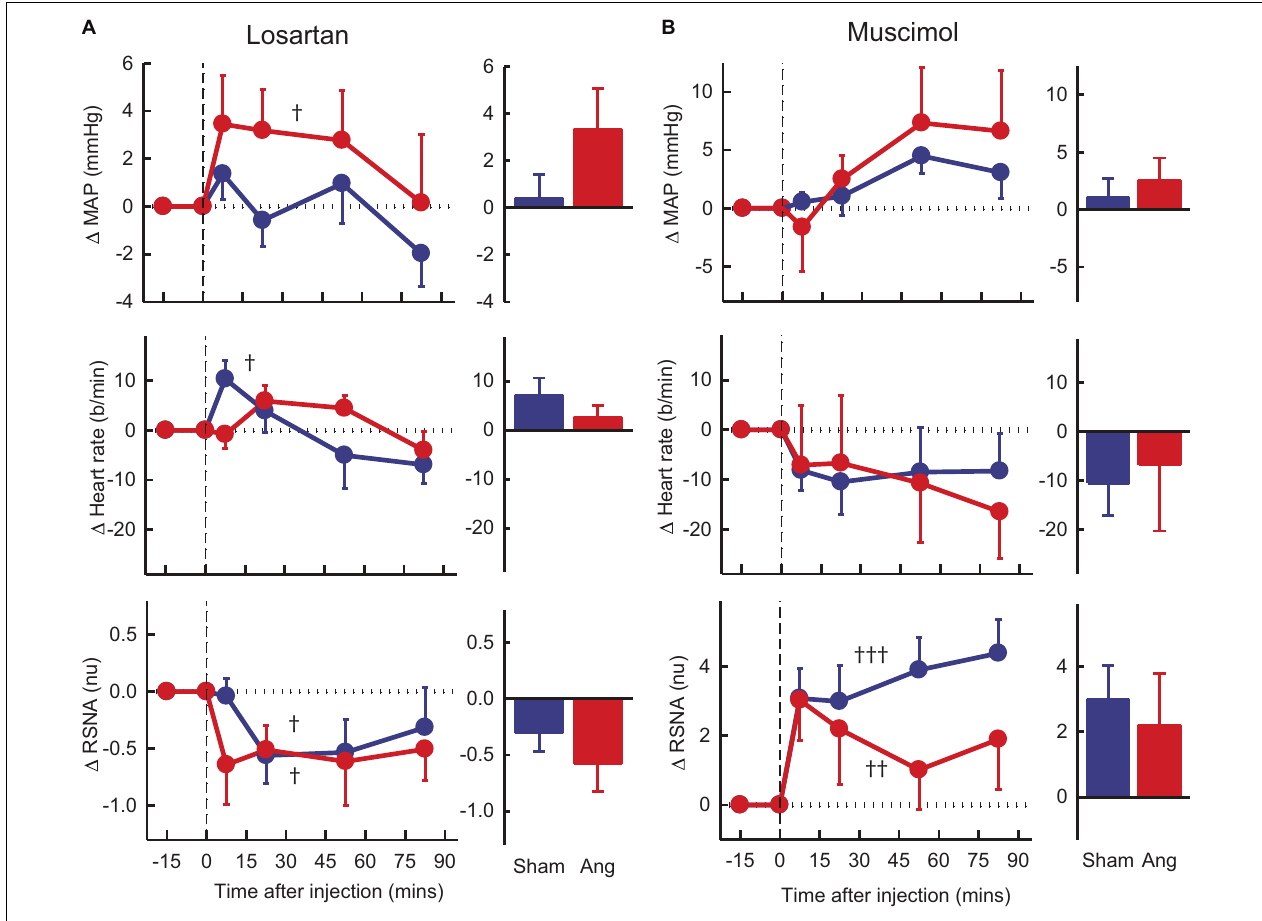
FIGURE 5 | Average changes in mean arterial pressure (MAP), heart rate and renal sympathetic nerve activity (RSNA, normalized units) in rabbits treated with bilateral PVN microinjections of losartan and muscimol. (A) Line graphs are mean difference from control ± SED after losartan (5 nmol) microinjection shown at dashed vertical line in sham (blue circles, n = 7) and Ang II (red circles, n = 7) rabbits. † P < 0.05, †† P < 0.01, and ††† P < 0.001 for change from control at 30–60 min. Bar graphs show average difference from control ± SED 0–30 min from injection. Family wise error rate was controlled using a modified Bonferroni procedure. (B) Changes after Muscimol (2 nmol) injection, averaged at 0–30